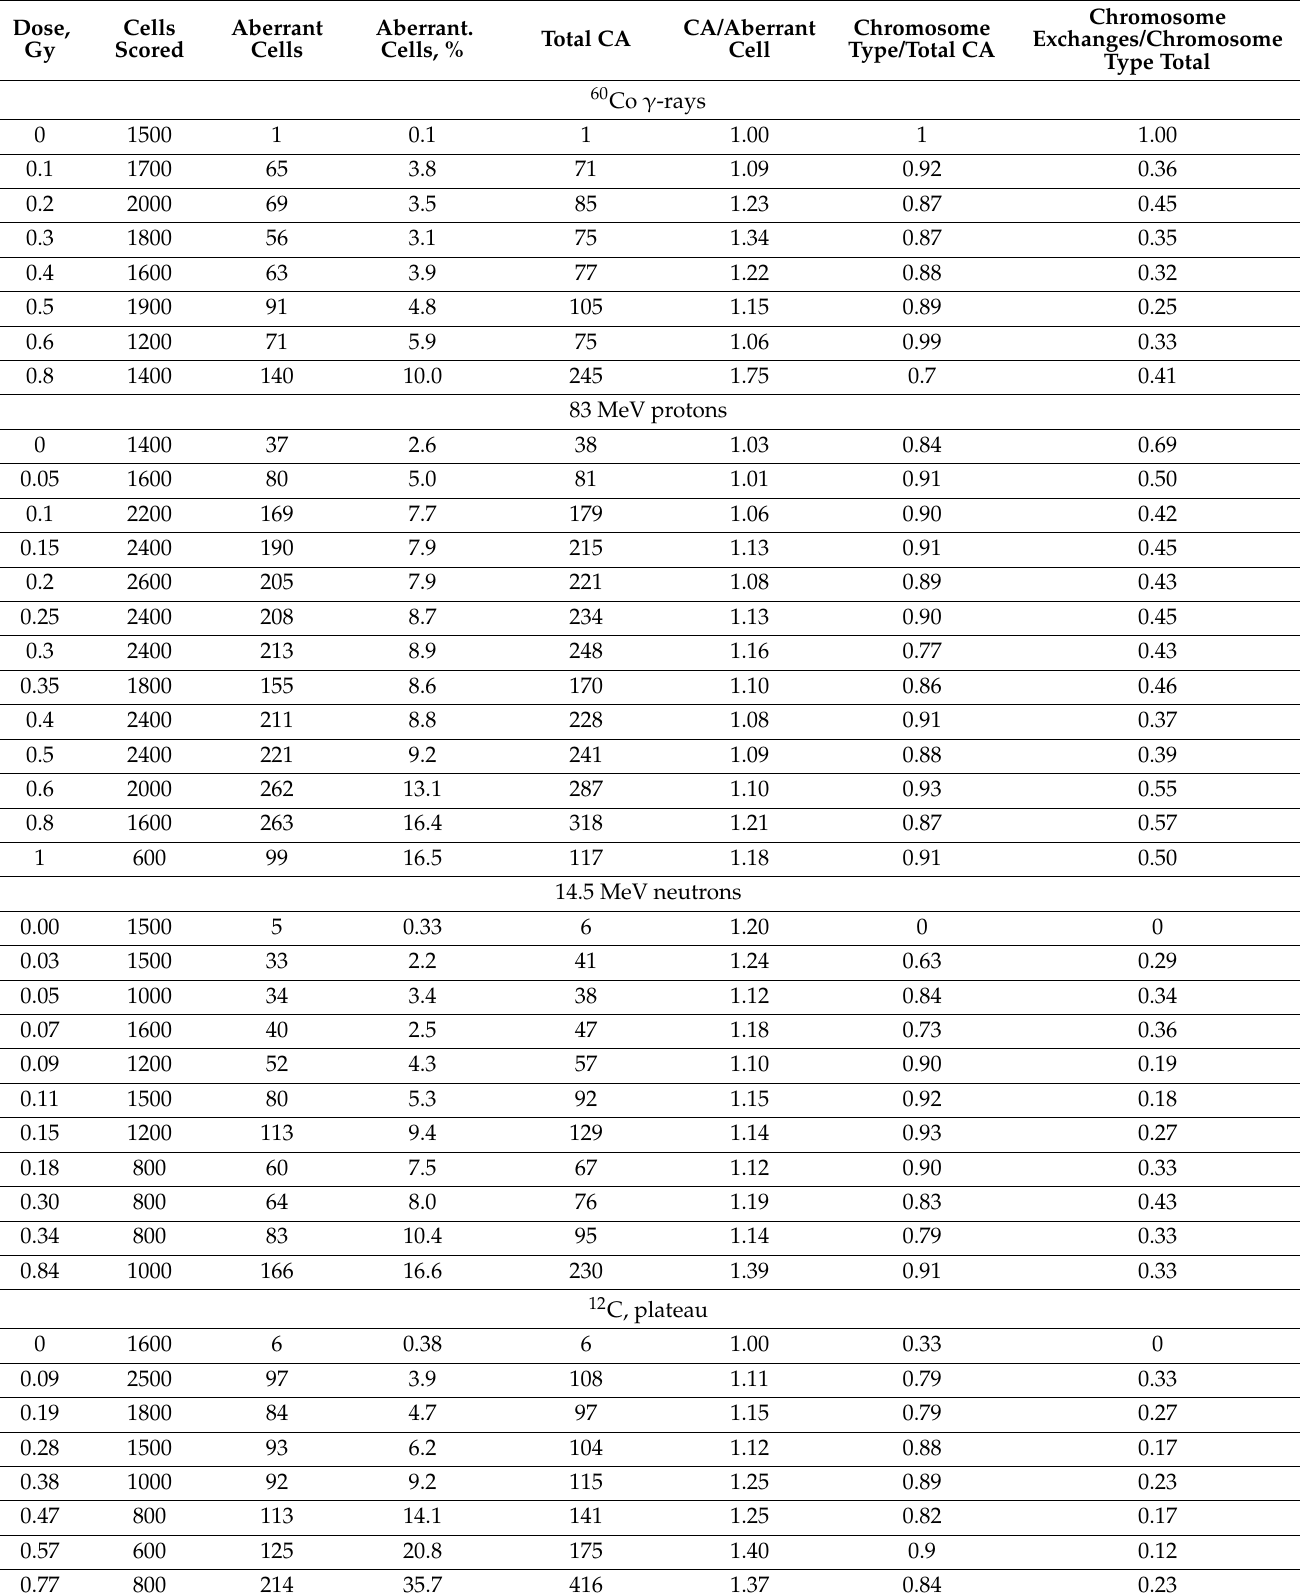
Table 1. Cytogenetic parameters of CHO-K1 cell population exposed to low doses of radiations with different LET